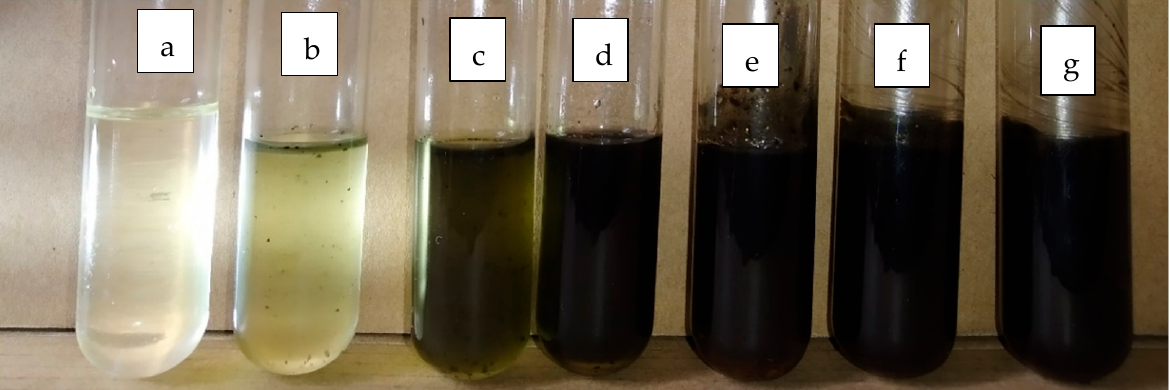
Figure 6. Image of emulsion F25 in the test tube varying in conidia content; ( a ) emulsion blank, emulsion loaded with conidia at ( b ) 0.1%, ( c ) 0.5%, ( d ) 1%, ( e ) 5%, ( f ) 7.5%, and ( g ) 10%.